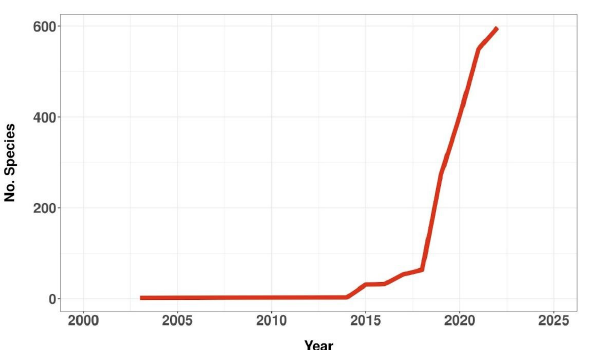
Figure 2. Accumulated number of fungi species published on the Red List since the first two lichens were assessed in 2003.